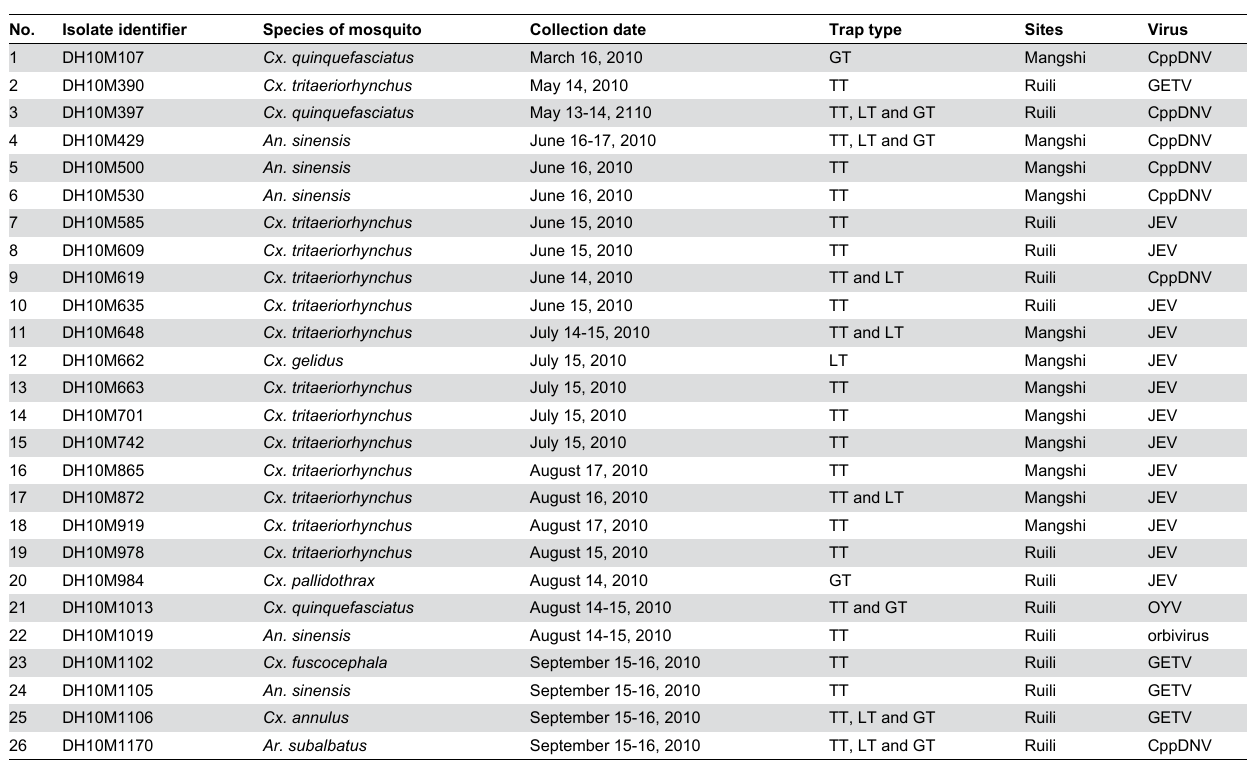
Table 6. Summary of viruses isolated from mosquitoes collected in Ruili and Mangshi, Yunnan Province 2010.